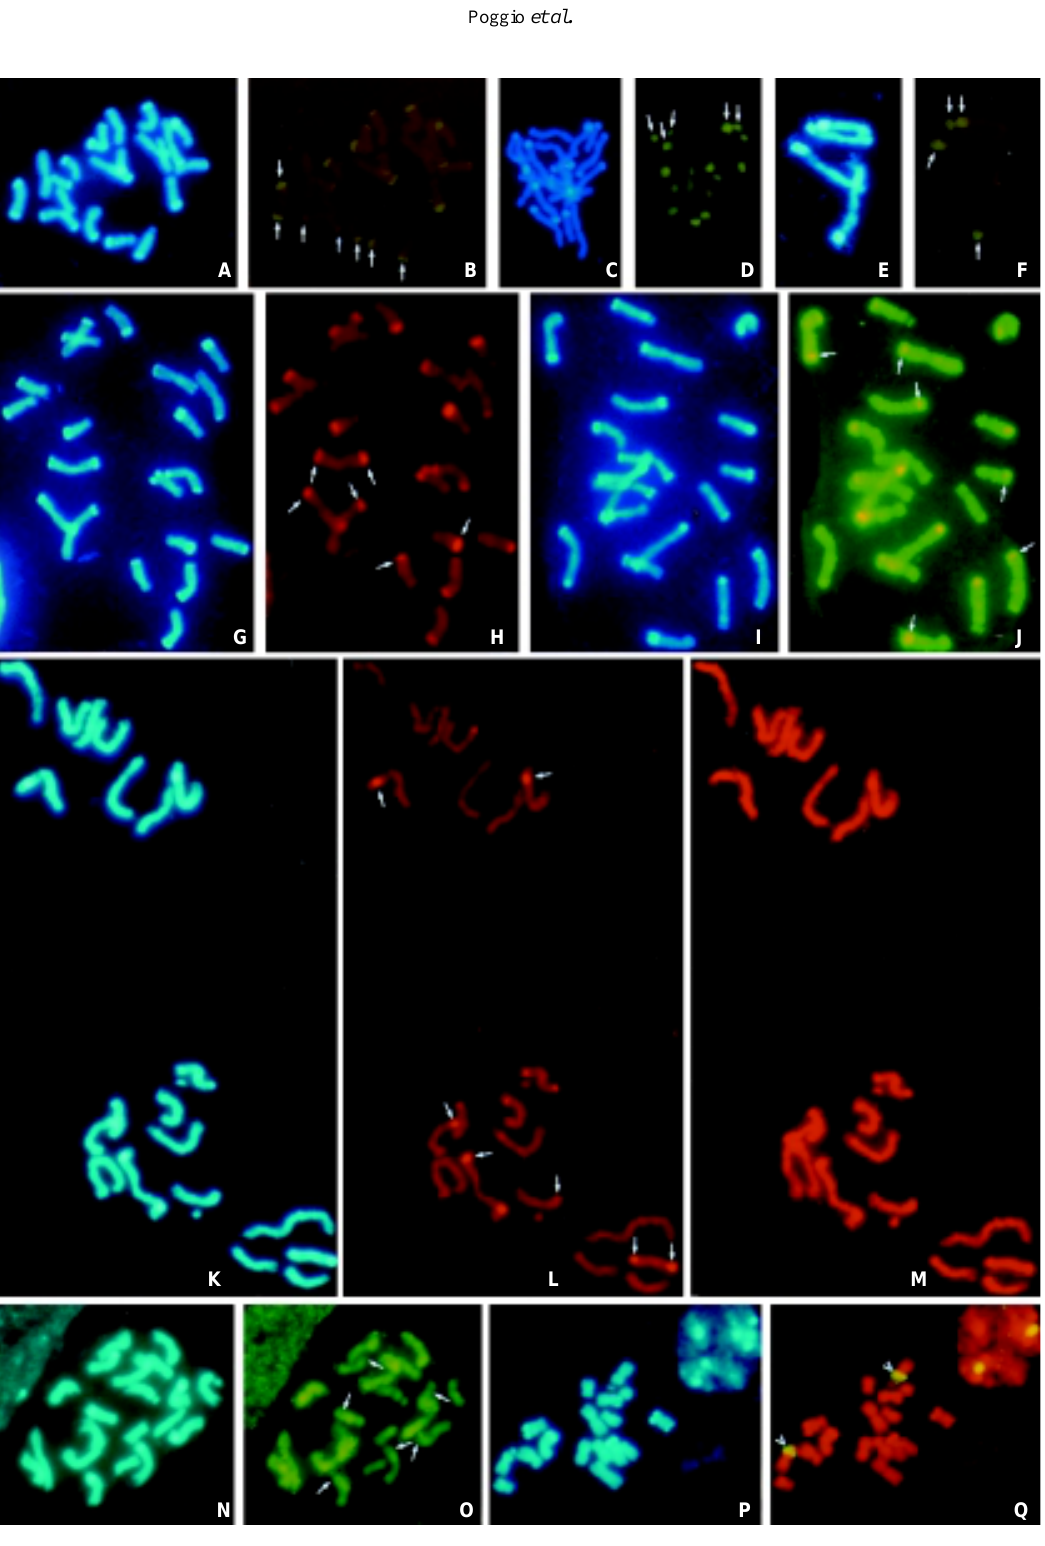
Figure 2 - A - J , Mitotic cells of Z. luxurians. A , Metaphase. C , Prophase. A , C , E , G , I , DAPI counterstaining. B , D , F , FISH using knob probe, detected with yellow green FITC (arrows indicate some of the telomeric regions with fluorescent regions coincident with DAPI + bands). E , Detail from four prophase chromosomes. H , GISH using DNA from Z. luxurians as a probe, detected with red Cy3, blocked with DNA from Z. perennis (arrows indicate some of the regions with strong fluorescence coincident with DAPI + bands). J , GISH using DNA from Z. luxurians as a probe detected with yellow green FITC, blocked with Z. diploperennis (arrows indicate some of the subtelomeric regions with fluorescence coincident with the DAPI + bands). K - Q , Mitotic cells from Zea mays ssp. mays. K , N , P , DAPI counterstaining. L , GISH using Z. luxurians DNA as a probe detected with avidin Texas red (arrows indicate some of the regions with strong fluorescence coincident with DAPI + bands). M , GISH using Z. diploperennis DNA as a probe detected with avidin Texas red. O , GISH using total DNA from Z. perennis as a probe detected with yellow green FITC (arrows show some of the regions of DAPI + bands exhibiting weaker fluorescence). Q , Double exposure photograph using total DNA from Z. diploperennis as a probe (red) and pTa 71 (yellow green, indicated with